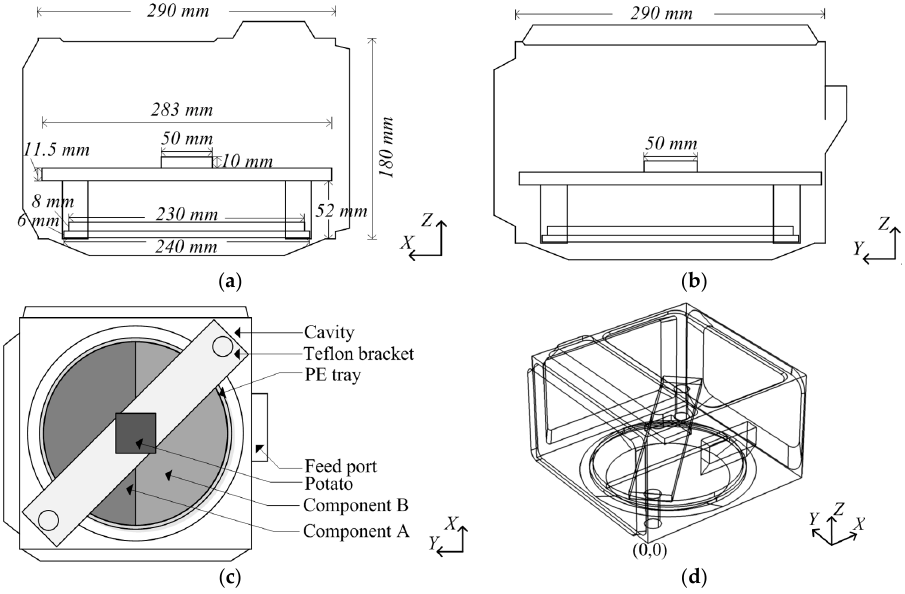
Figure 2. Geometry of the 3-D microwave oven: ( a ) y - z plane view; ( b ) x - z plane view; ( c ) x - y plane top view; and ( d ) 3D view.